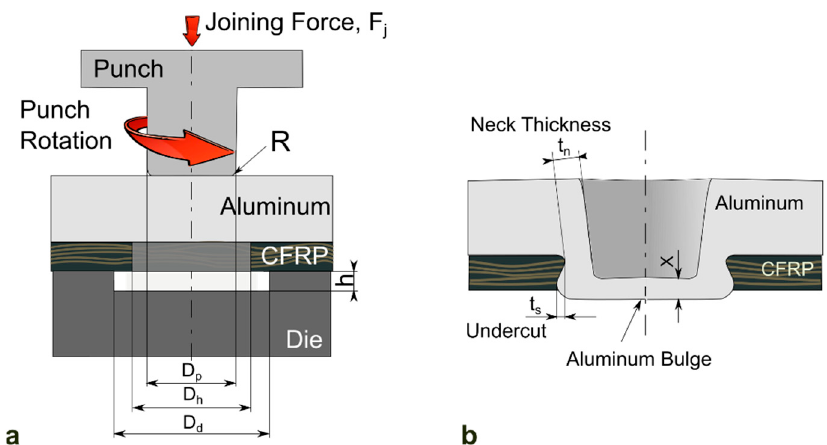
Figure 4. Schematic of ( a ) friction assisted (hole) clinching and ( b ) resulting geometrical interlocking of a clinched joint (Reprinted with permission from [48]).